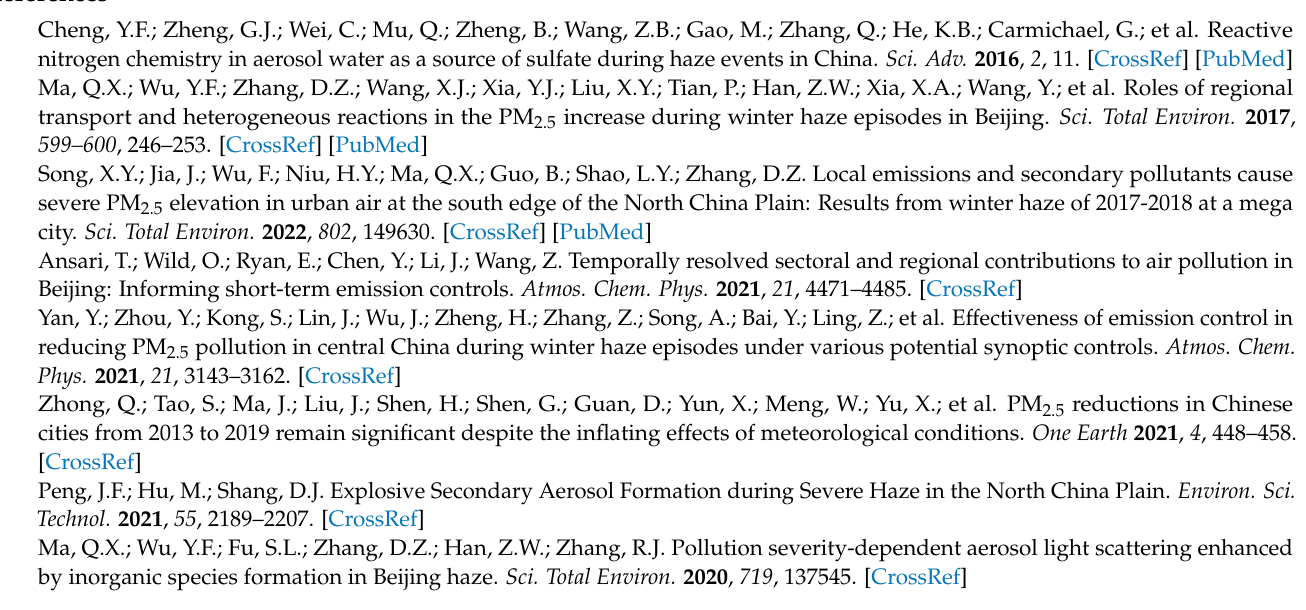
(bars) resolved from the PMF model (in units of µ g µ g − 1 ) and contribution percentages (black dots) from each source